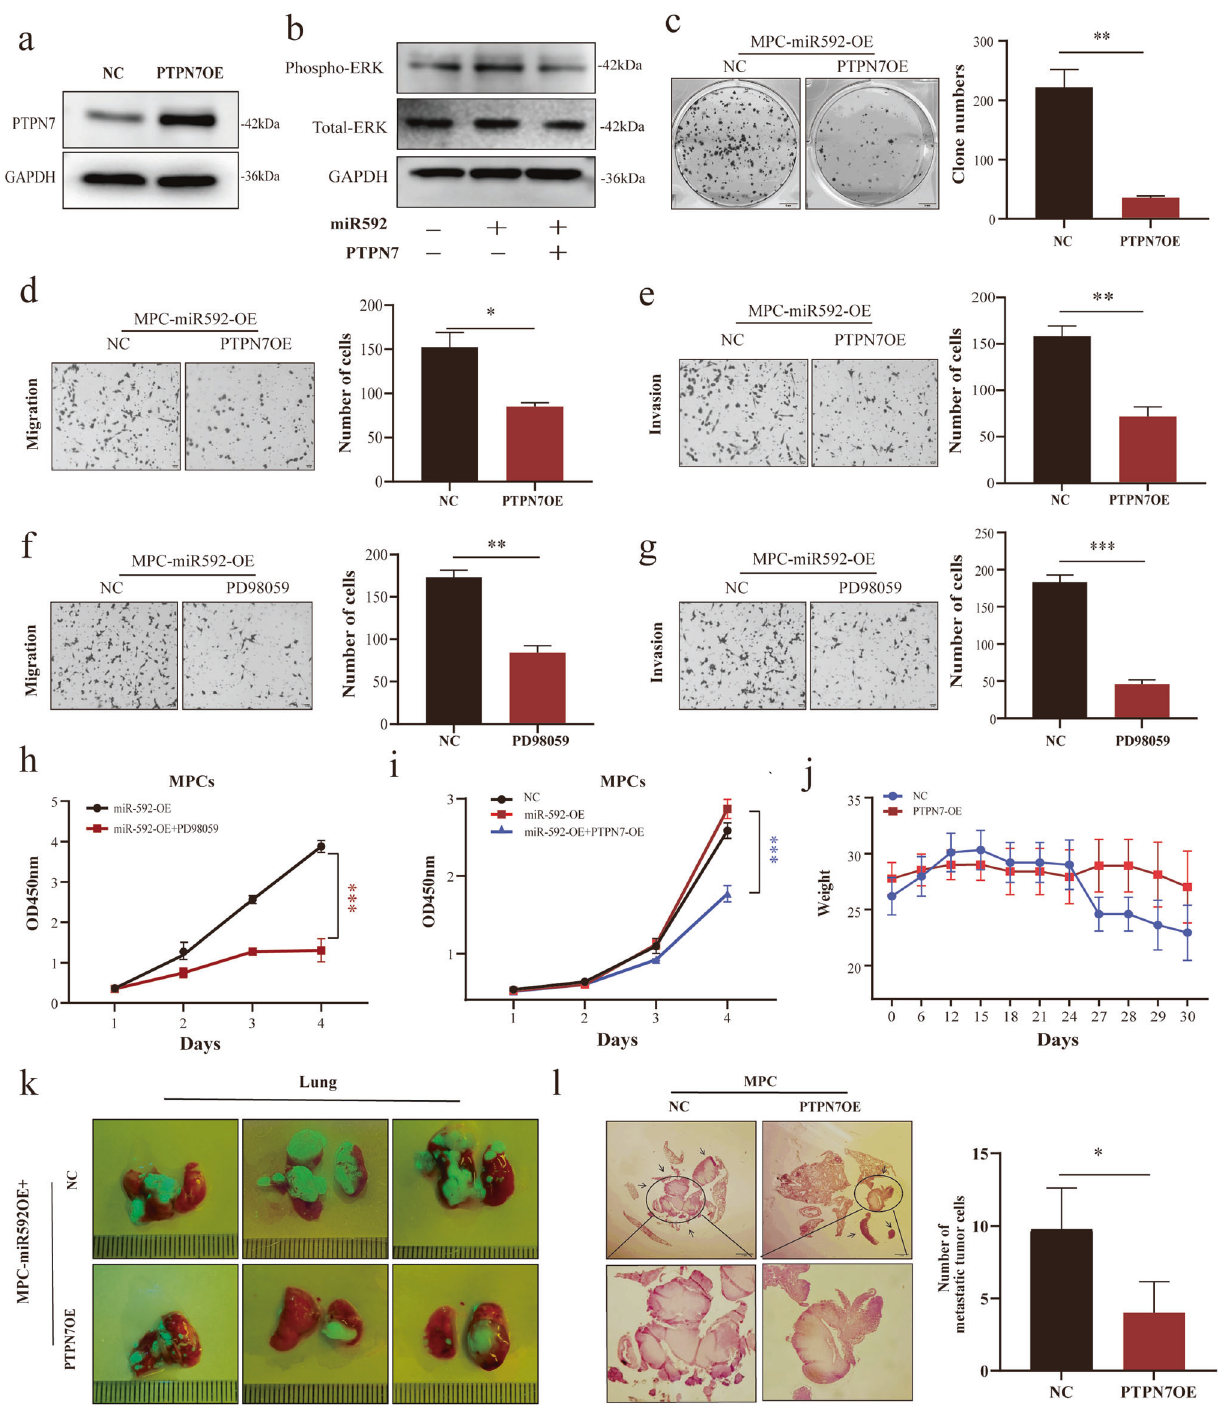
Fig. 5 PTPN7 overexpression revered the pro-metastatic activity of miR-592 in MCP cells. a The overexpression ef fi ciency of PTPN7 was veri fi ed by WB. b Western blot analysis on the effect of miR-592 and PTPN7 on phospho-ERK and total-ERK. c – e Colony formation and Transwell assays revealed that miR-592 mediated oncogenic effects could be attenuated by PTPN7. f – h Migration, invasion and CCK-8 assays indicated that the oncogenic effect of mir-592 could be mediated by MAPK/ERK inhibitor PD98059 (20 μ M). i The effect of PTPN7 overexpression on the proliferation of miR-592-OE-MPC cells was determined by the CCK-8 assay. j Weight changes in mice injected with control and PTPN7 overexpressed MPC cells. k Pulmonary metastasis in mice. The overexpressed PTPN7 was labeled with GFP (green fl uorescence). l Lung metastasis was observed by H&E staining and quanti fi ed by Image J (ns not signi fi cant; * P < 0.05; ** P < 0.01; *** P < 0.001). However, the involvement of EVs secreted by CSCs in melanoma CSCs are cells with self-renewal capability and play essential roles metastasis has not been investigated. Our present study has made in oncogenesis and metastatic progression [33 – 35]. CSCs derived EVs the following novel fi ndings that have elucidated a new mechanism can modify the oncogenic properties of the recipient tumor cells [36]. of melanoma metastasis based on CSC extracellular vesicles: EVs-miRNAs of CSCs can enhance metastatic progression [37 – 39]. Cell Death Discovery (2022)